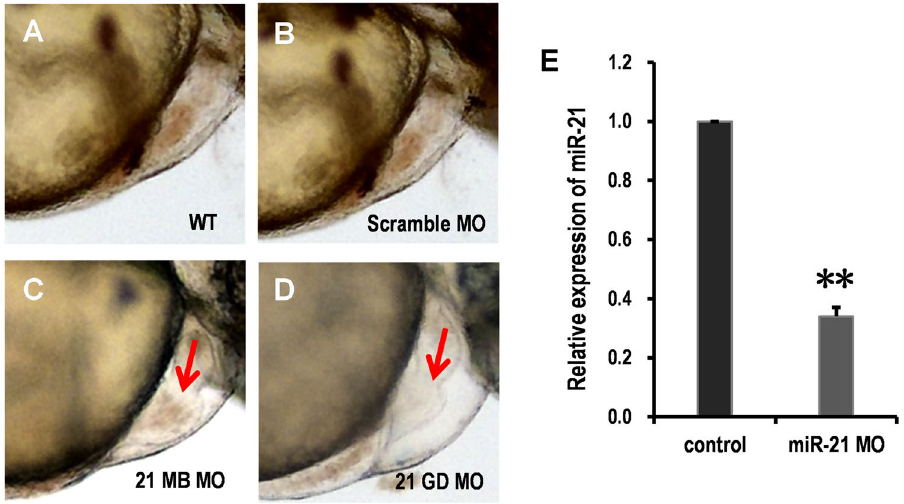
Figure 1. The effect of miR-21 knockdown on the zebrafish valve development. ( A – D ) Both wild-type and scramble MO control-injected embryos show normal AV ring constriction (( A , B ) arrow) at 55 hpf, whereas miR-21 knockdown results in loss of the normal AV constriction (( C , D ) arrow) ( E ) Relative expression of the mature miR-21 was measured by qRT-PCR using RNA isolated from the whole bodies. Injection of miR-21 MOs knocked down the expression of miR-21 to nearly 30%. ** P <